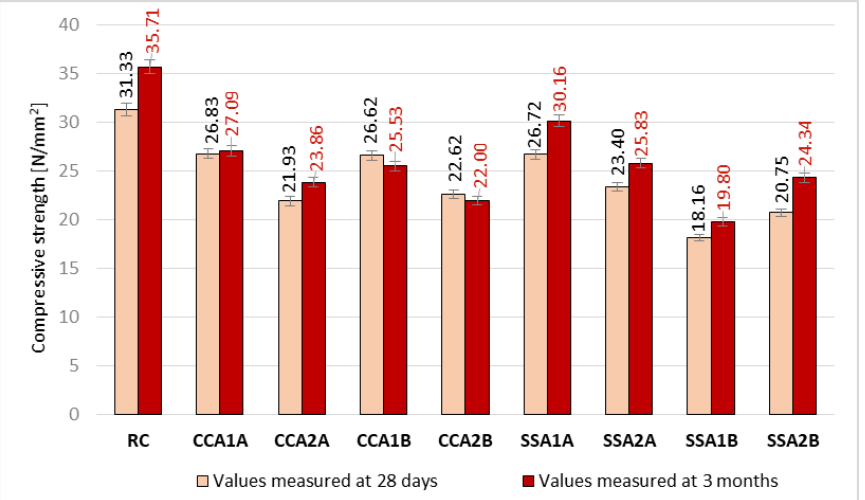
Figure 6. Compressive strength values at 28 days and 3 months age (N/mm 2 ).